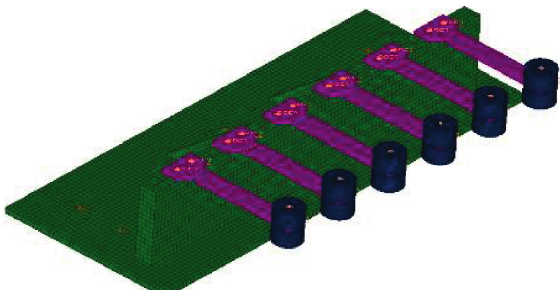
Figure 9: PSD of the accelerated test.